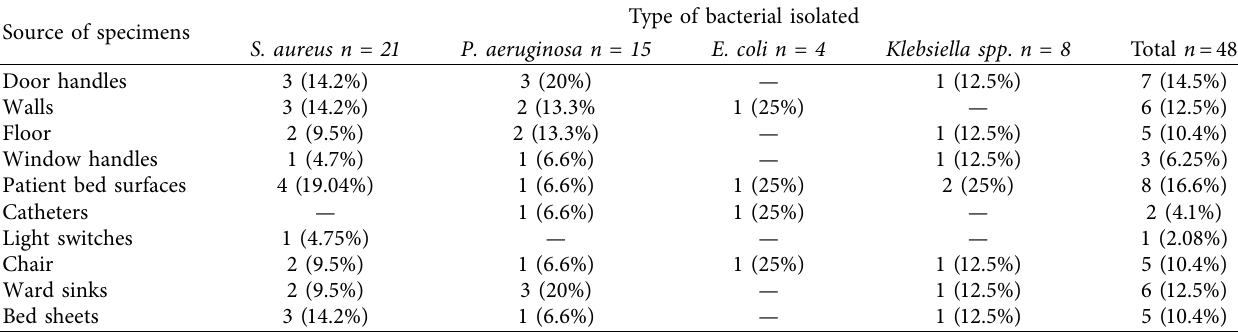
Table 2: Distribution of bacterial isolates in surfaces over operation theater ward, WSUCH, Wolaita Sodo, Southern Ethiopia, 2021. Source of specimens